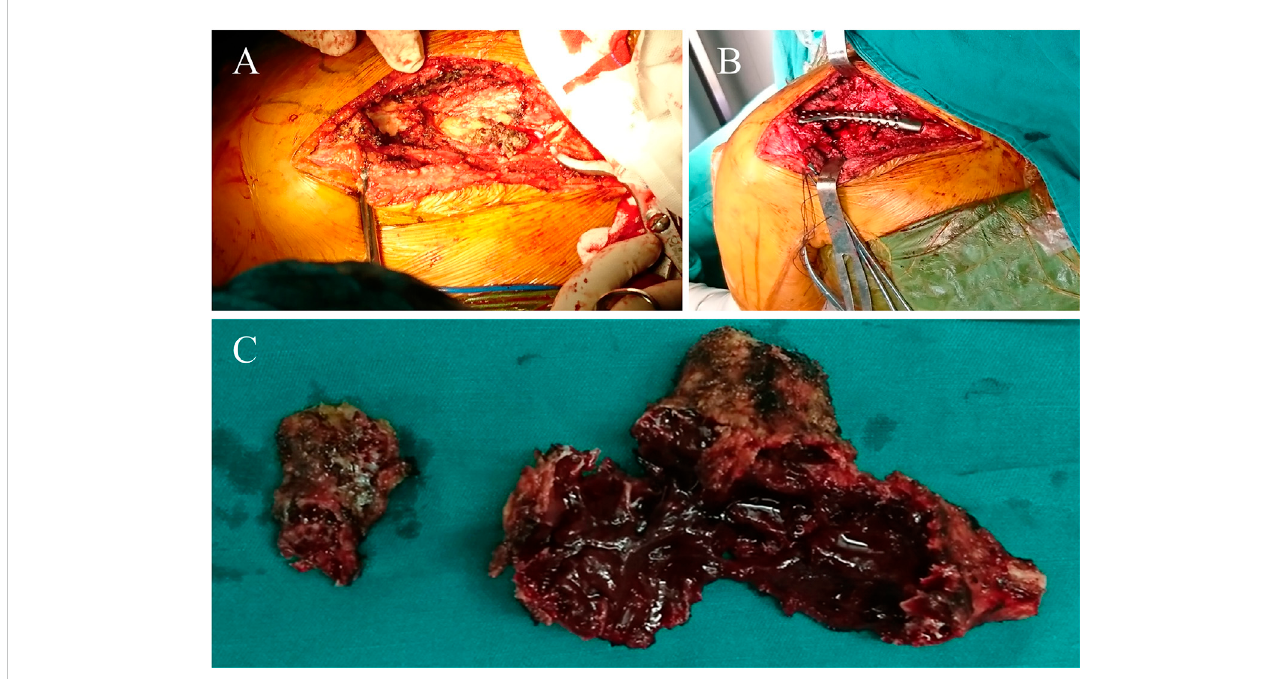
FIGURE 5 Intraoperative pictures. (A) Resection of the lateral clavicle was performed. (B) Implantation of the prosthesis. (C) Photograph of the resected tumor